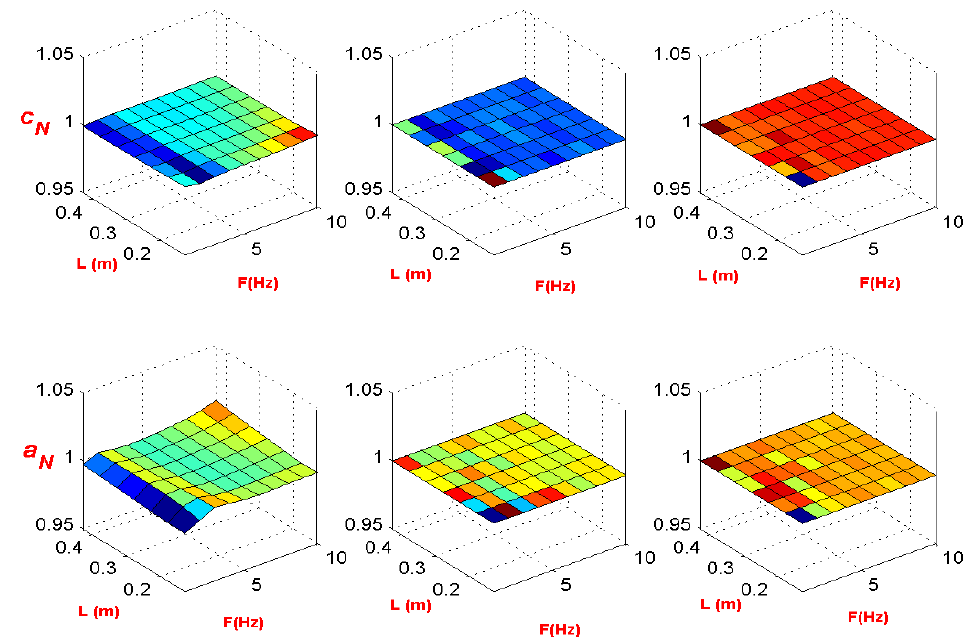
Fig. 7 Three dimensional view (see legend Fig.2) of frequency pattern of normalized phase velocity and normalized attenuation for various vessel length ( L = 12.8, 17.8, 22.8, 27.8, 32.8, 37.8 and 42.8 cm